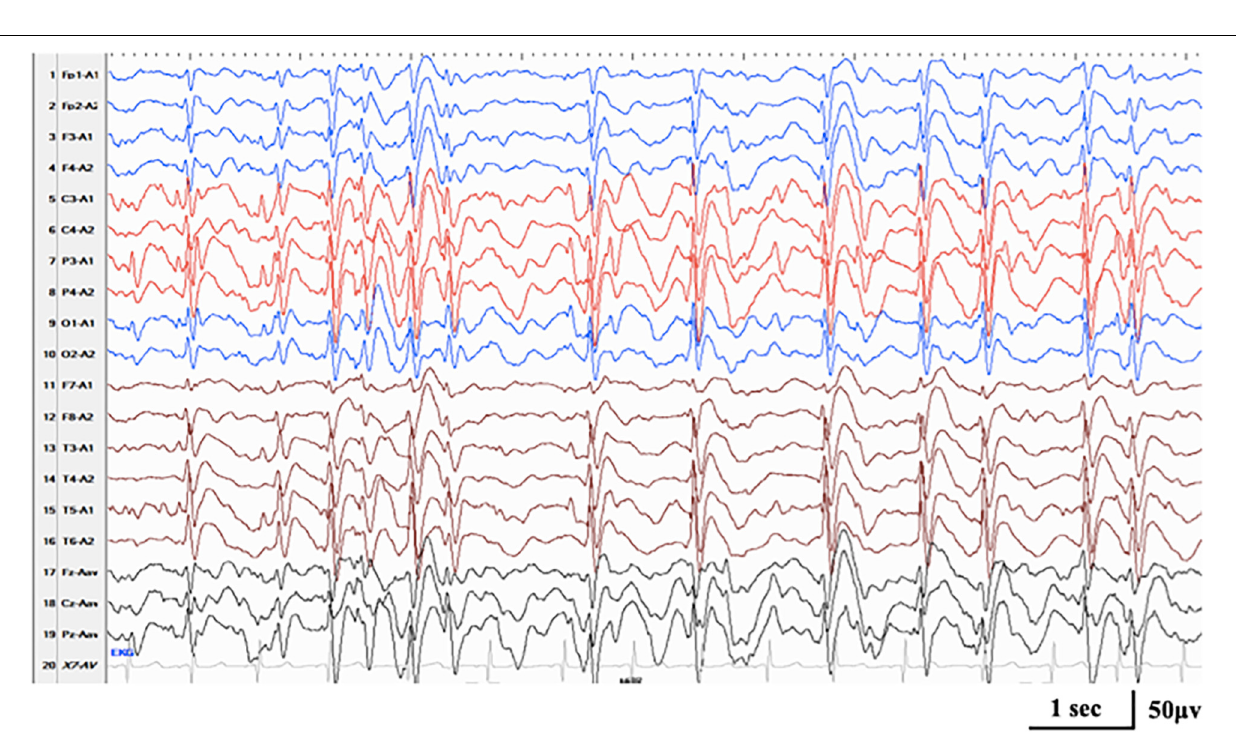
Frontiers in Genetics |